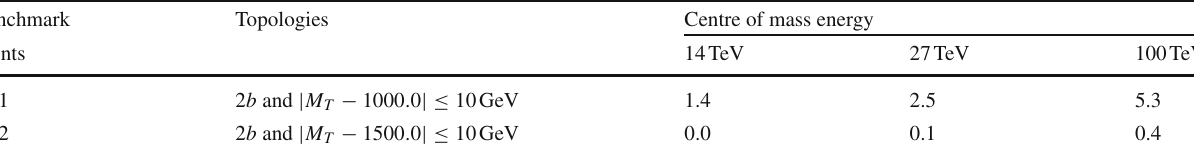
Table 11 The number of events in M T distributions after the window cuts around the mass peak at the LHC/FCC for the benchmark points at the centre of mass energies of 14TeV, 27TeV and 100TeV at the